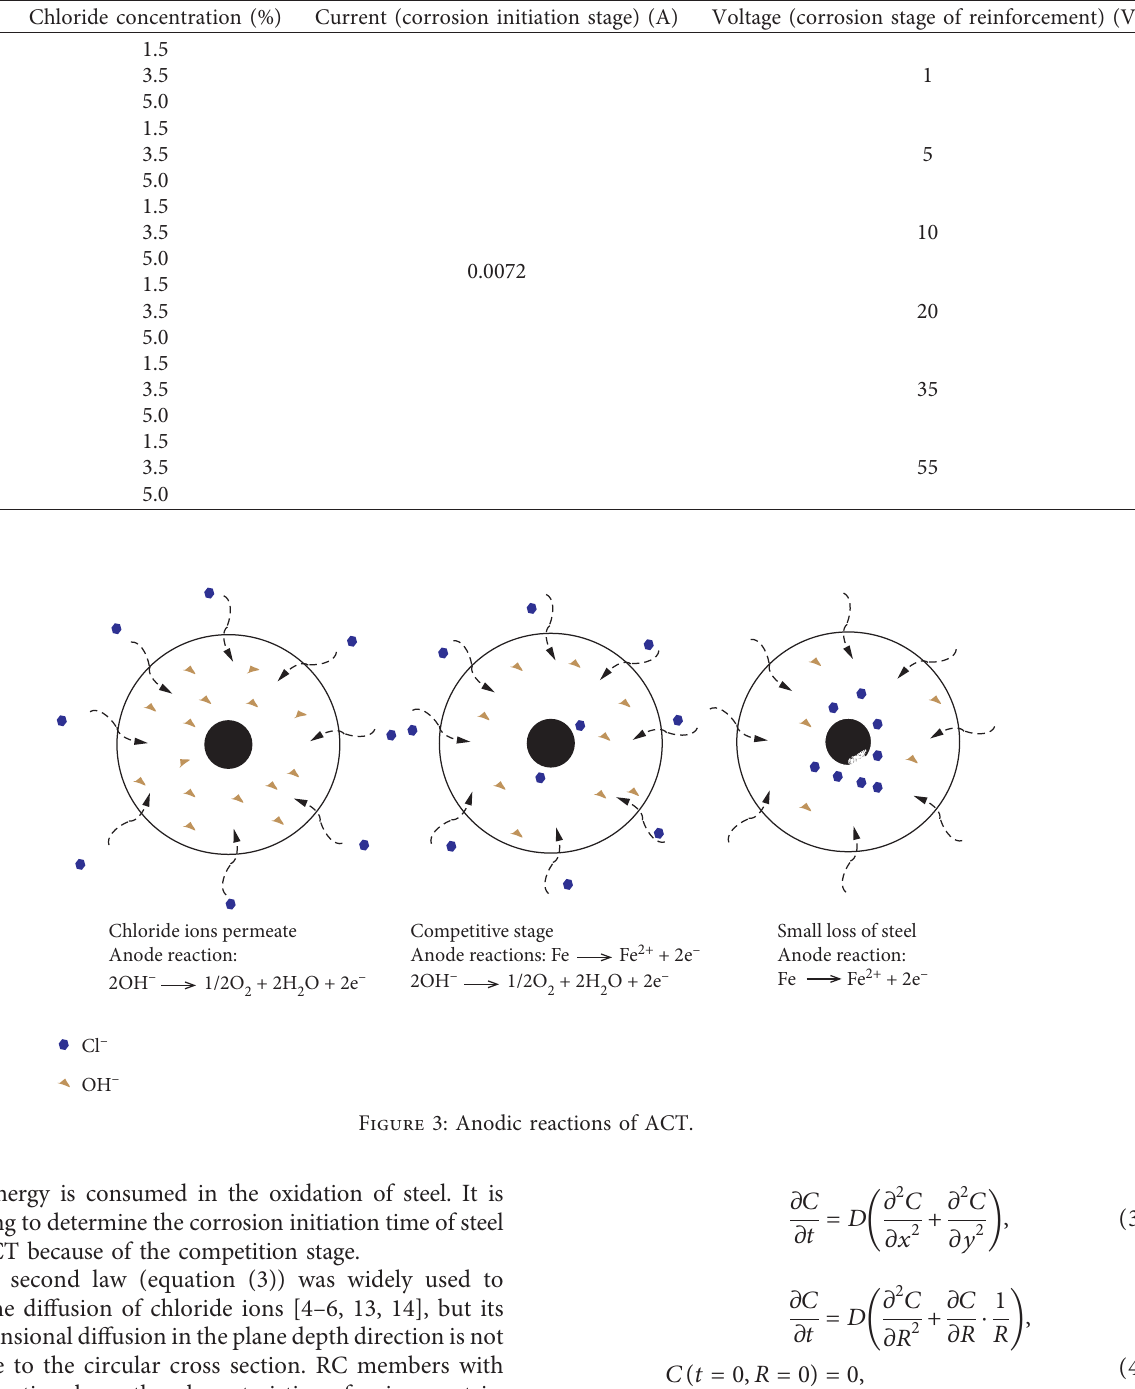
Table 3: Test matrix.